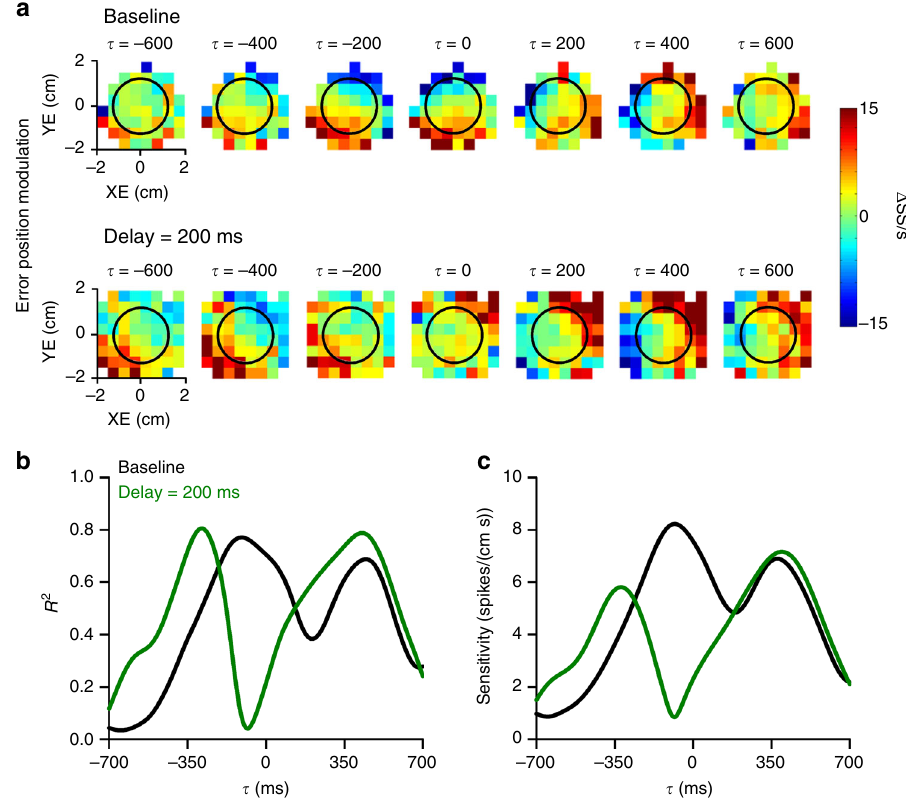
Fig. 3 Visual feedback delay shifts predictive encoding of position error. a Firing maps for an example Purkinje cell with lead and lag SS position error modulation in both baseline (top row) and 200 ms delay (bottom row) conditions. Each map indicates SS modulation at a speci fi c lead (negative τ ) or lag (positive τ ). Black circle indicates target edge. R 2 ( b ) and sensitivity ( c ) temporal pro fi les for the Purkinje cell shown in a computed using linear regression analyses (see Materials and Methods) that quanti fi es the SS encoding of position error in both the baseline (black line) and 200 ms delay (green line) conditions. As for the fi ring maps, negative τ indicates lead SS